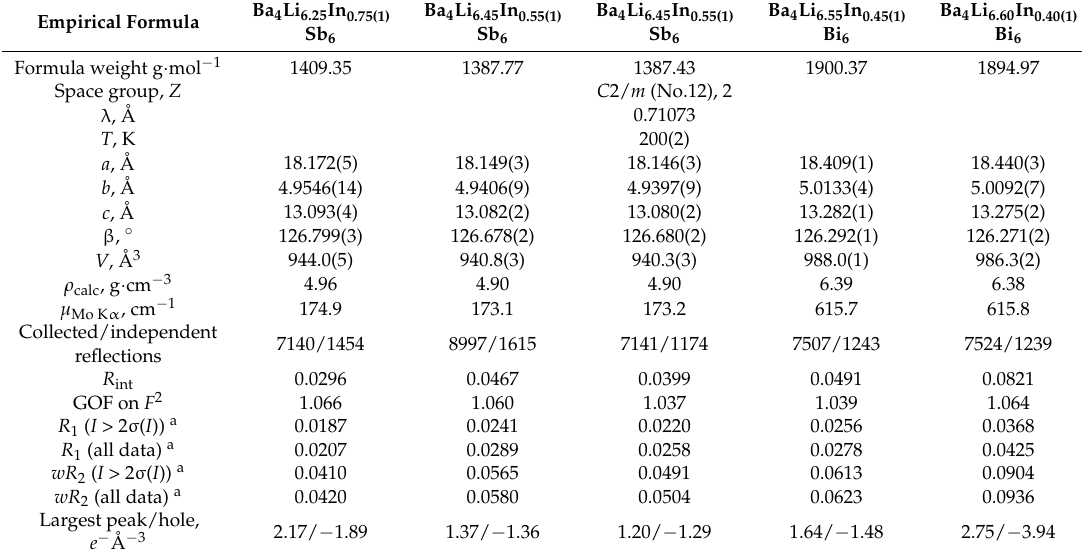
Table 2. Selected crystal structure data and refinement parameters for Ba 4 (Li 1 − x In x ) 7 Sb 6 and Ba 4 (Li 1 − x In x ) 7 Bi 6